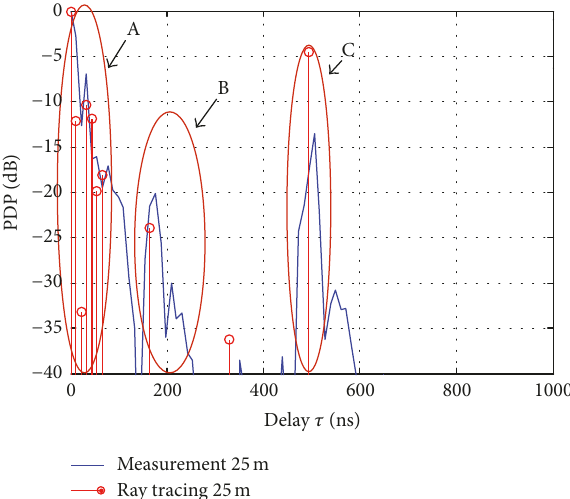
Figure 7: A PDP example for the 25 m link distance.